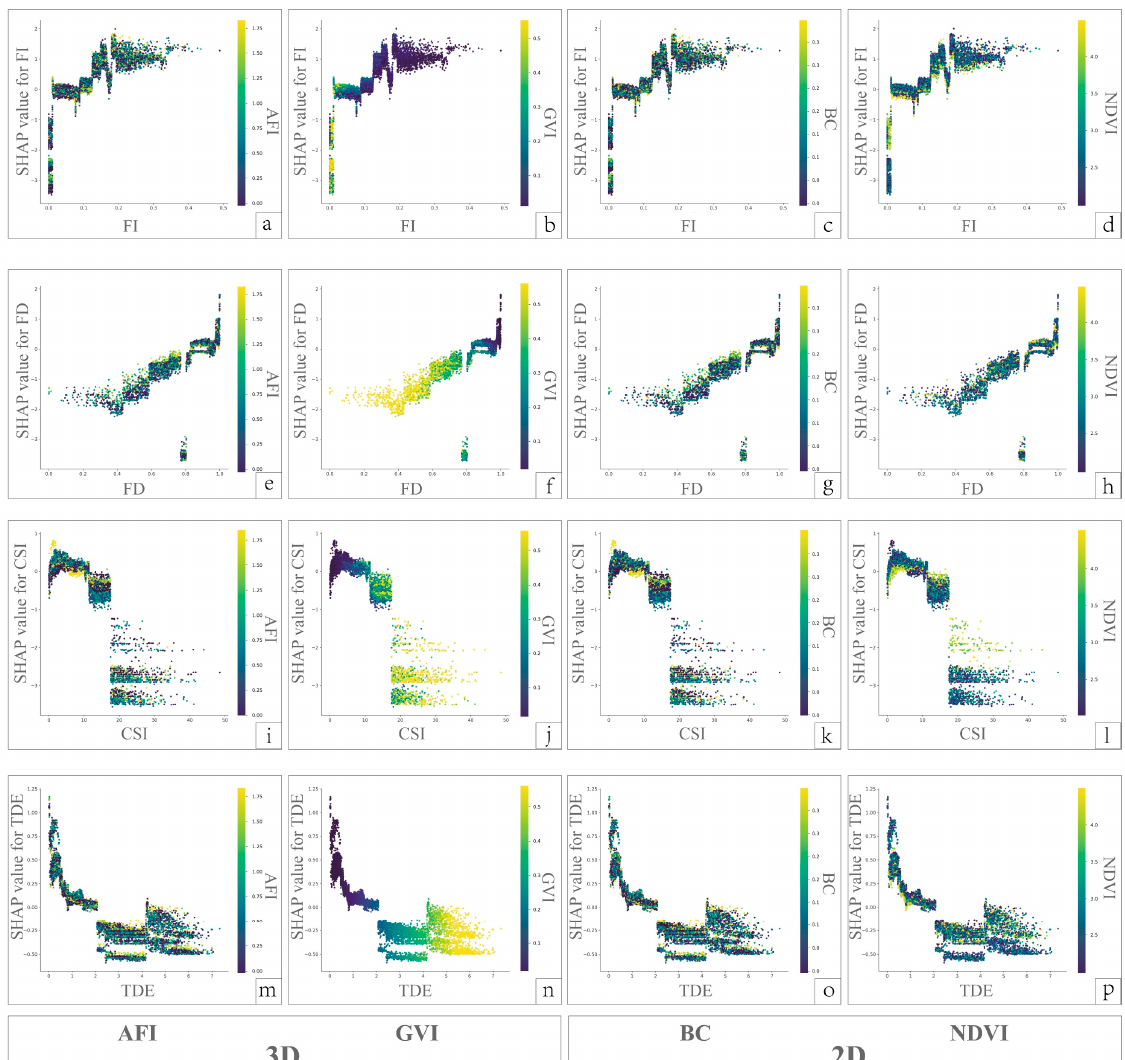
Figure 8. Analyzing the bivariate interaction mechanism between street green space morphology and the surrounding built environment through the dependency graph. Among them, subgraphs ( a – p ) are the bivariate interaction mechanism of FI, FD, CSI and TDE, respectively. Figure 8e–h show the interaction effects of FD with the surrounding built